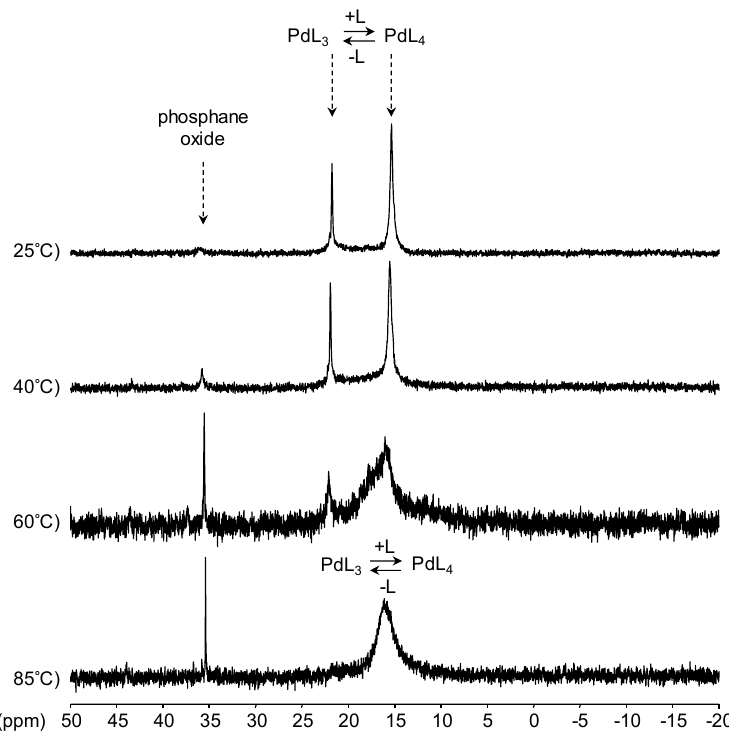
Figure 13. 31 P{ 1 H} NMR spectra of palladium complexes synthetized with P(Biph) 3 TS depending on temperature in D 2 O with a ligand concentration of 66 mM.